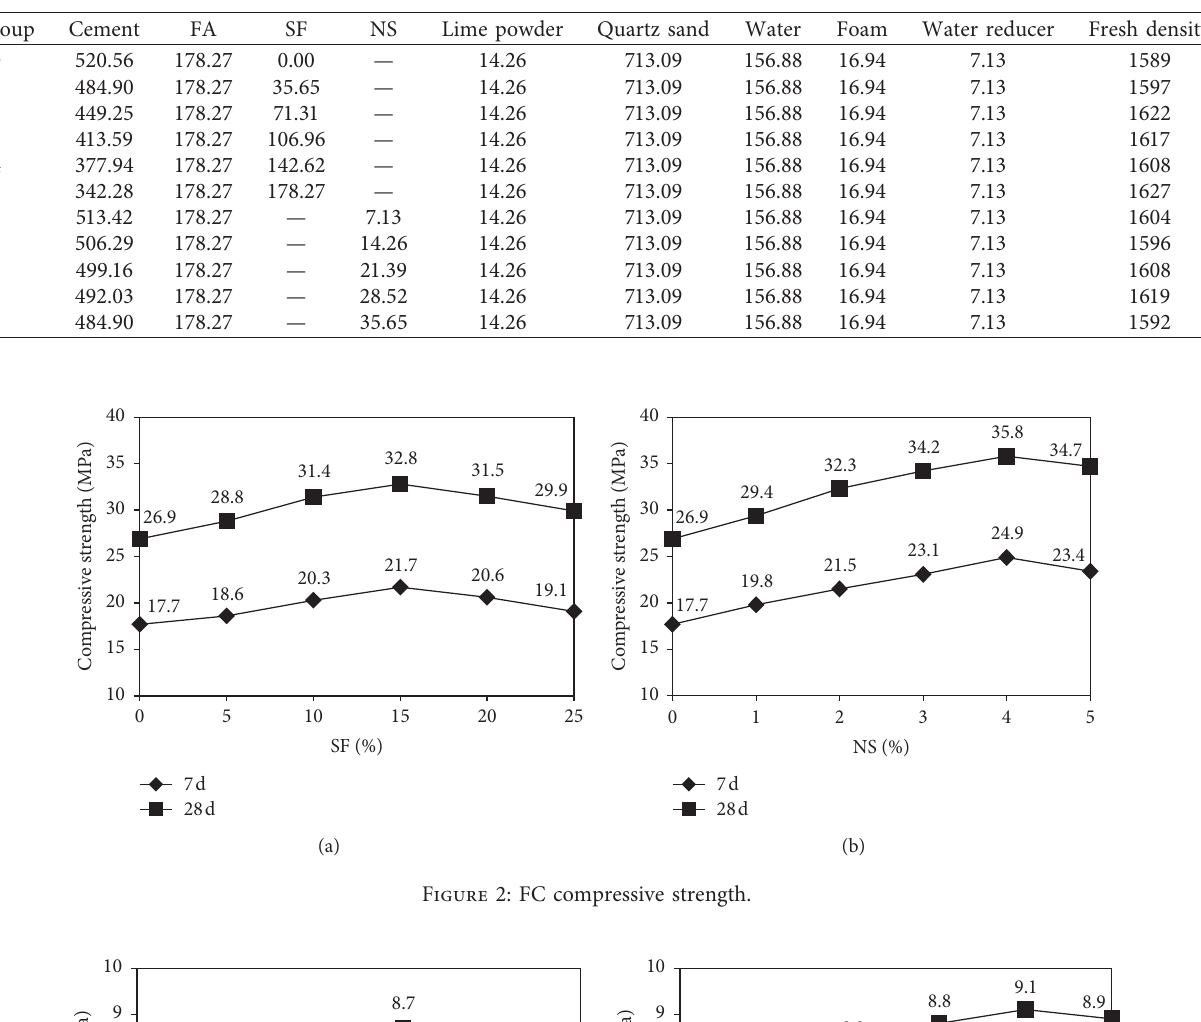
Table 8: Mix proportion design (unit: kg/m 3 ).